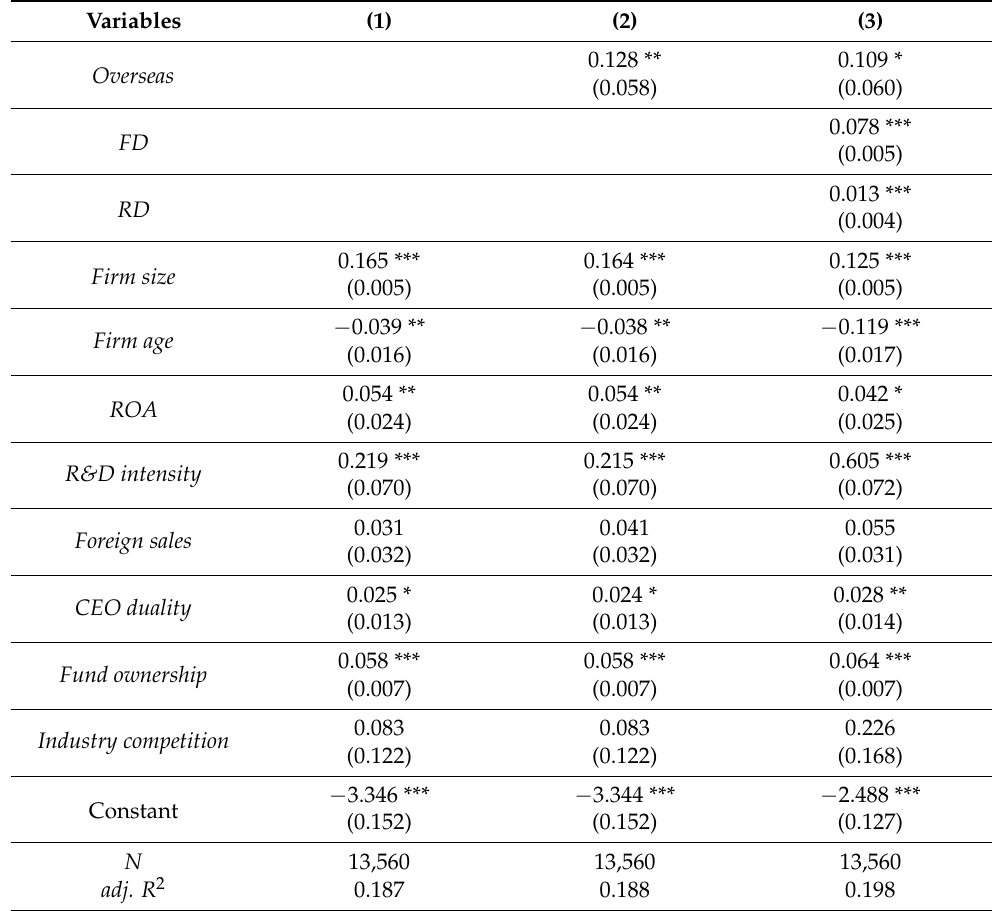
Table 4. Baseline Regression